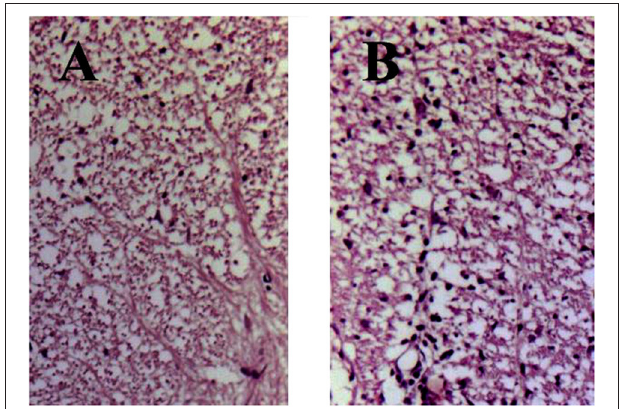
FIGURE 2 | EAE rats histology of spinal cord sections stained with hematoxylin and eosin (day 13, p.i.). Rats were treated daily with immunocortin 400 µ g/kg (A) or normal saline (B) .